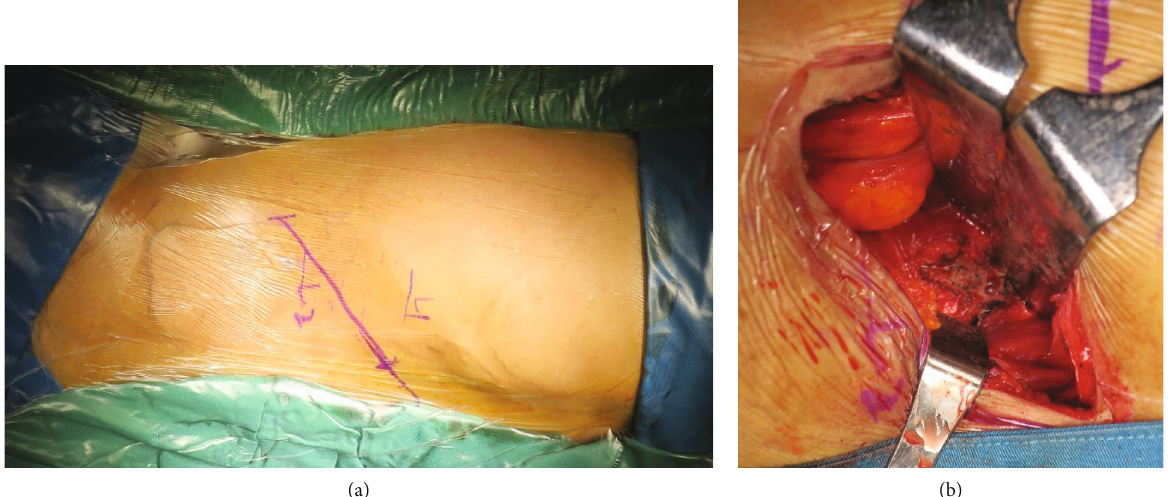
Figure 2: Lumbotomy approach with (a) left lateral skin incision to assess (b) thoracolumbar vertebral level.